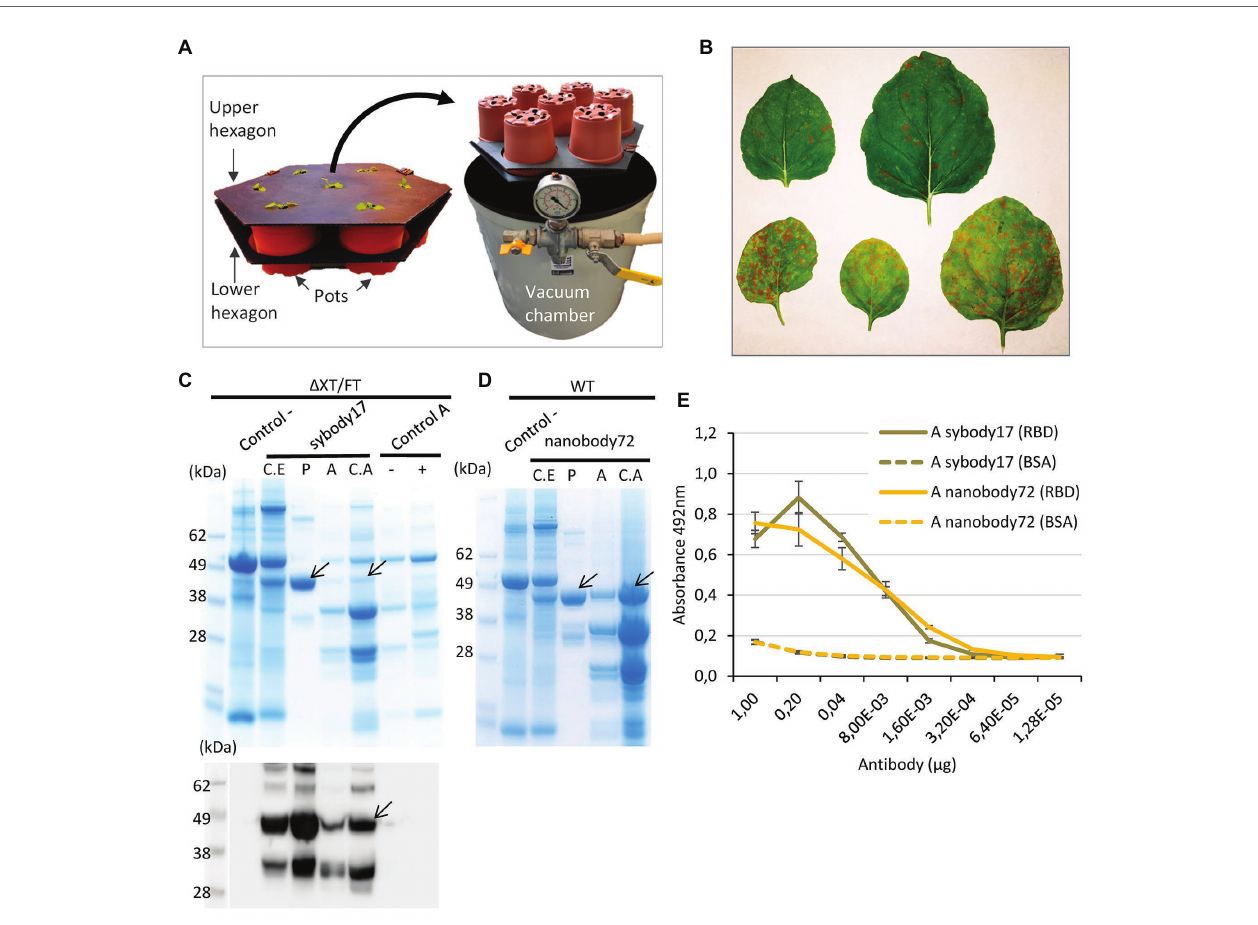
FIGURE 5 | Analysis of upscaling production of anti-RBD sybody17 and nanobody72 antibodies as an example for a pilot assay. (A) Hexagon growth modules used in the pilot assay with N. benthamiana plants and vacuum degas chamber used for vacuum agroinfiltration. (B) Different agroinfiltrated Δ XT/FT N. benthamiana leaves with DsRed tiles as indicator of the extension of the recombinant protein production. (C) Coomassie stained SDS gel and Western blot of protein extracts from Δ XT/FT plants expressing sybody17. (D) Coomassie stained SDS gel of protein extracts from WT plants expressing nanobody72. Total crude extract (C.E), purified extract (P), total apoplastic fluid (A) and concentrated apoplastic fluid (C.A). Wild type crude extracts (control) and apoplastic fluid with (+) or without ( − ) DsRed expression were used as control samples. Seventeen microliter of total protein extract per well and 3 μ g of purified protein per well were loaded in SDS gels. Arrows show the position of each full-size antibody band. (E) Antigen ELISA titers graph of full-size antibody from apoplastic fluid of sybody17 and nanobody72- expressing plants. Binding activities were calculated by absorbance measurements at 492 nm. The X axis shows the amount ( μ g) of antibody per well. Solid lines indicate the ELISA test against commercial RBD, and dashed lines indicate the corresponding control ELISA tests against BSA. Bars represent mean ± SD, n = 3 independent